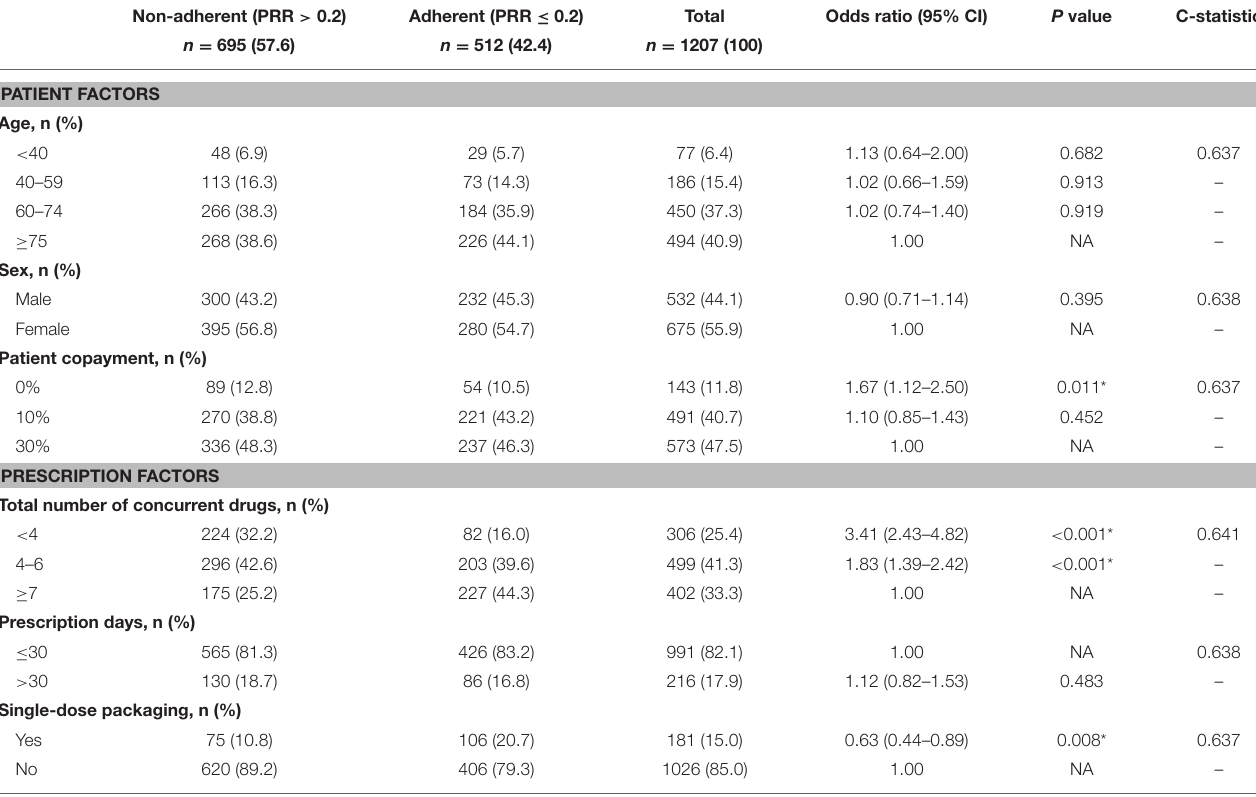
TABLE 2 | Factors contributing to non-adherence for all oral drugs. Non-adherent (PRR >